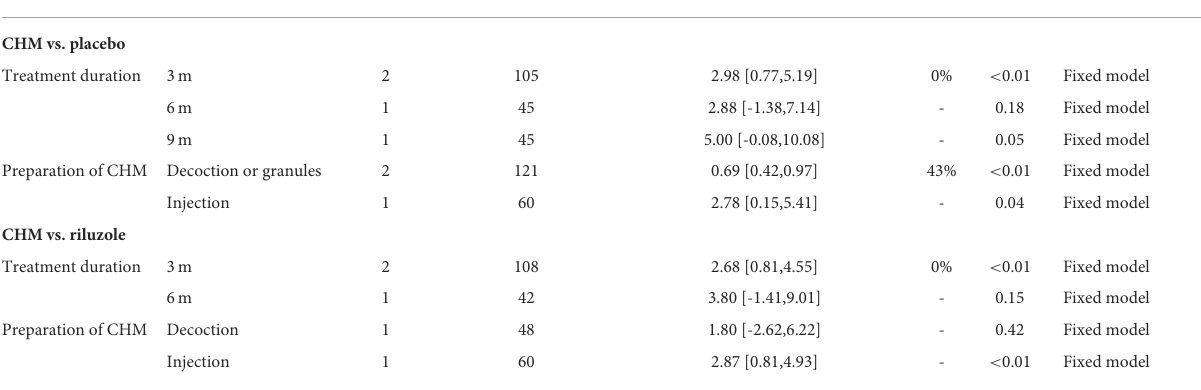
TABLE 3 Subgroup analysis of ALSFRS or ALSFRS-r based on treatment duration and preparation of CHM. Subgroup No. study No. participants Estimated effect (MD, 95% CI) I 2 P value Analysis